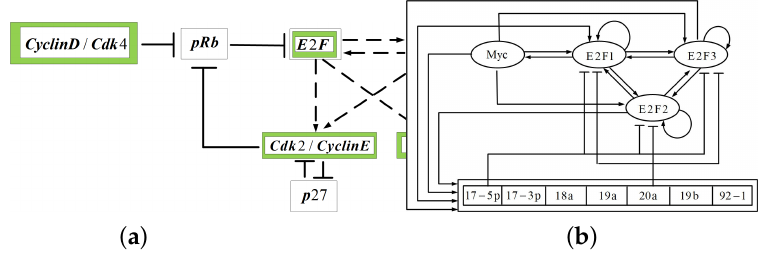
Figure 3. ( a ) Cancer network. ( b ) Myc/E2F/miR-17-92 gene regulatory network.